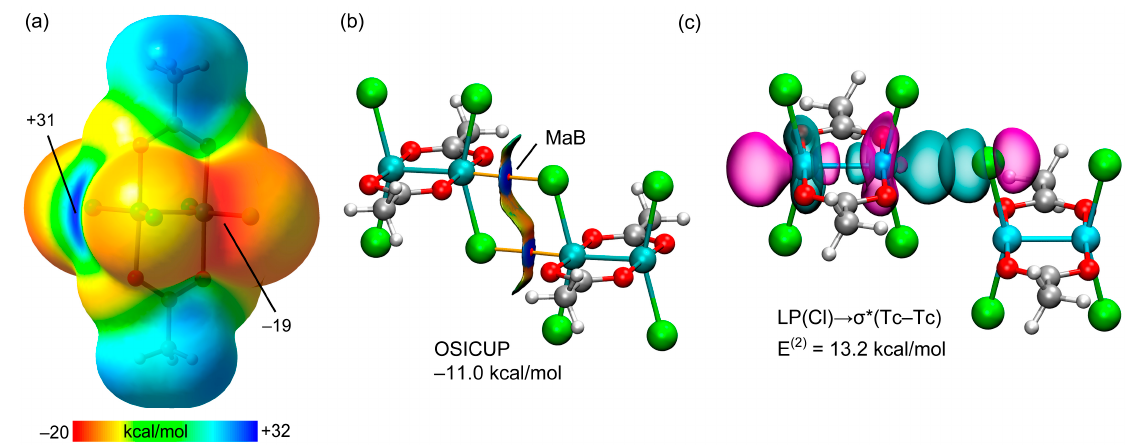
Figure 11. ( a ) MEP surface of OSICUP (isosurface 0.001 a.u.). Energies at selected points in kcal/mol. ( b ) QTAIM/NCIPlot analysis of the homodimer of OSICUP with indication of the dimerization energy. ( c ) Plot of the NBOs involved in the donor–acceptor interaction with indication of the E (2) energy. Color code: Carbon grey, Technetium teal, Oxygen red, Hydrogen light grey.